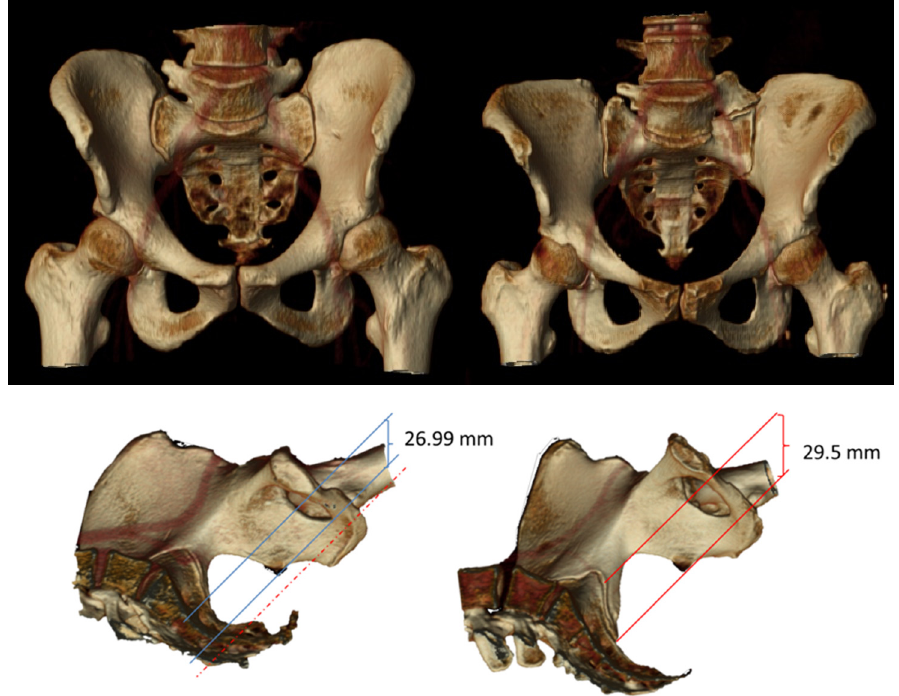
Figure 2. Three-dimensional reconstructions of a male and female pelvis in the coronal ( top ) and sagittal ( bottom ) planes through the pubic symphysis. Note the different morphologies of the male and female pelvis. Especially noticeable in the coronal reconstruction is the difference in the pelvic bone. The sagittal reconstruction shows the mean symphysis–ischial spine distance (SID), as measured between the planes of the pubic symphysis and the ischial spine in men and women. Note its higher value in women (29.50 mm vs. 26.99). The dotted line in the left image marks on the male pelvis the mean SID obtained in the